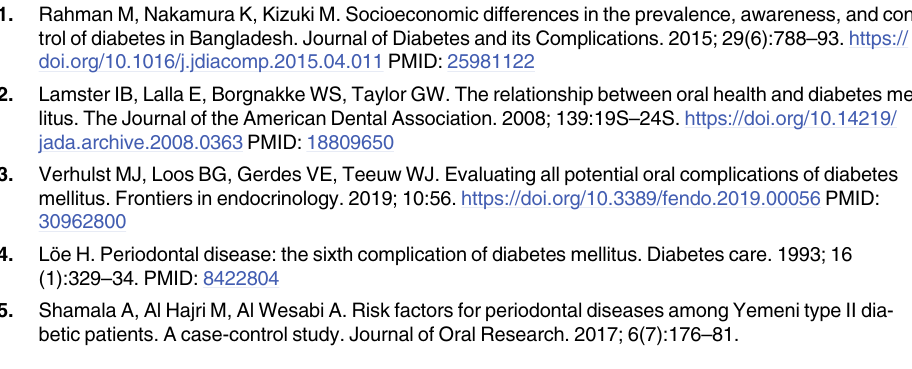
S1 Table. Adjusted odds ratio (AOR) for associations between measures of oral hygiene practices according to prevalence of periodontal disease among type 2 diabetics